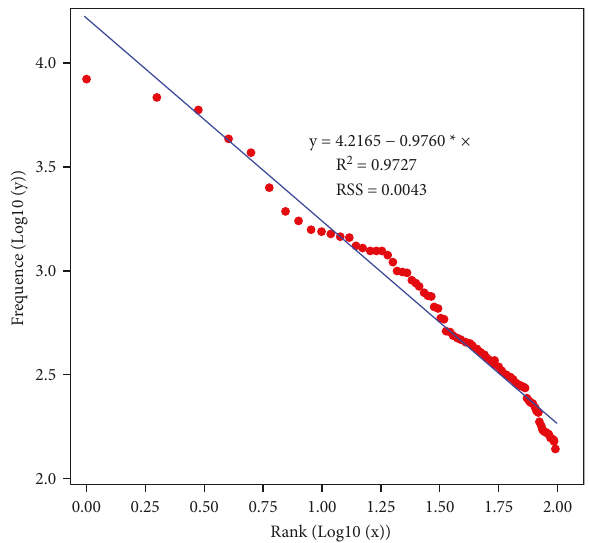
Figure 3: Frequencies of attractions and their rank relationship